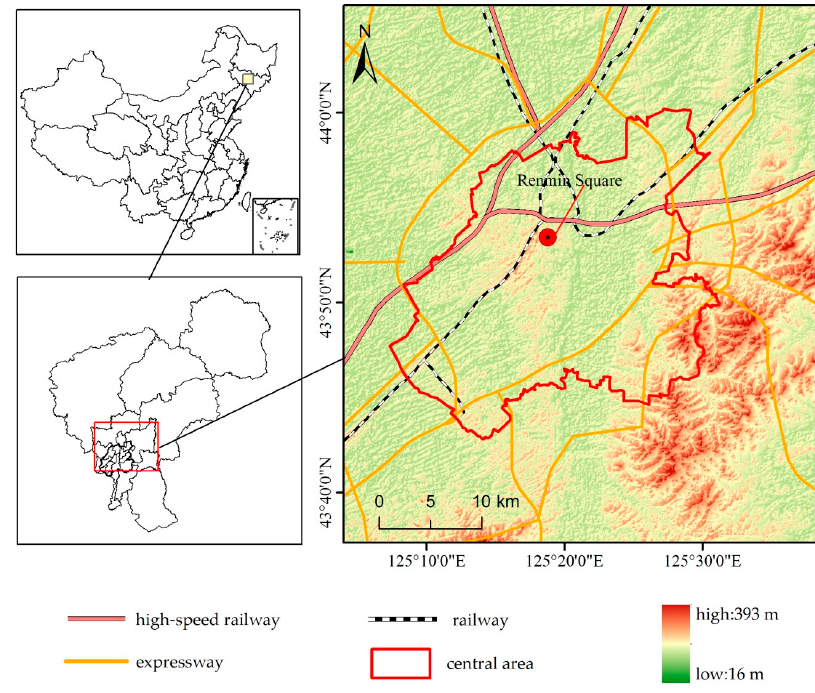
Figure 1. Location of the study area.